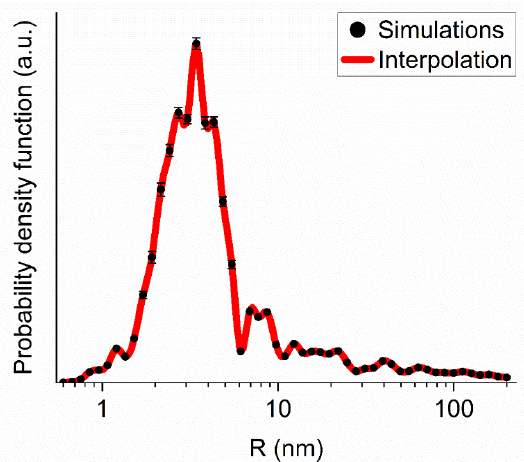
Figure 5. The probability density as a function of radius (in nm) evaluated within the model of discrete-size diamond nanospheres for the F-DND sample. Red circles show the simulation results. The red solid line interpolates the simulation